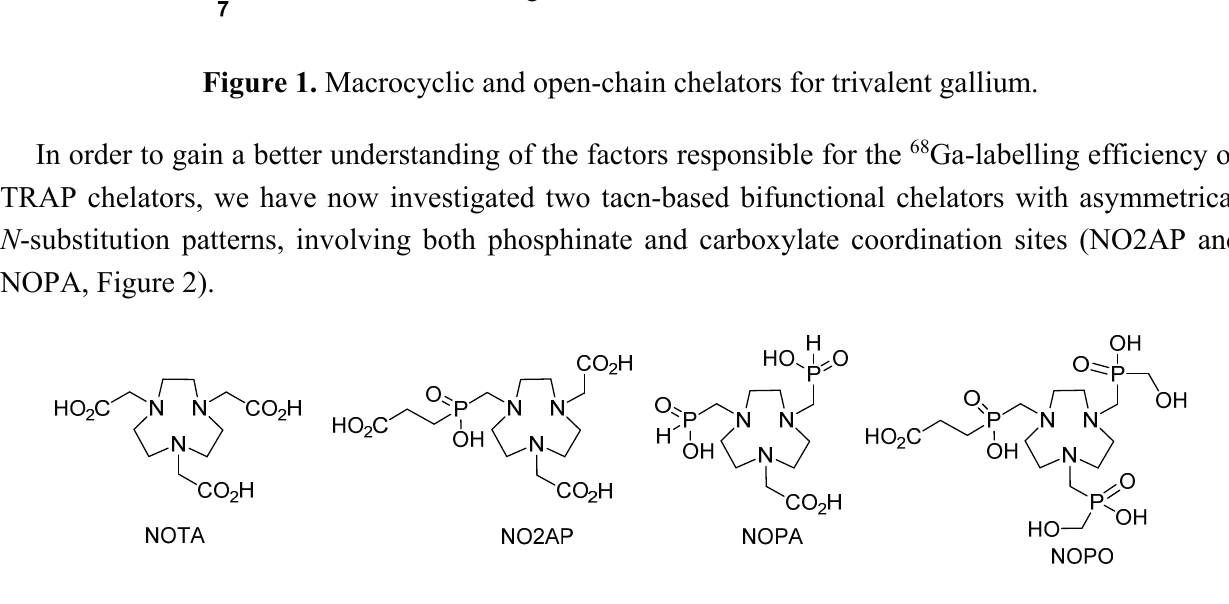
Figure 2. Chelators with acetic/phosphinic acid pendant arms compared in this